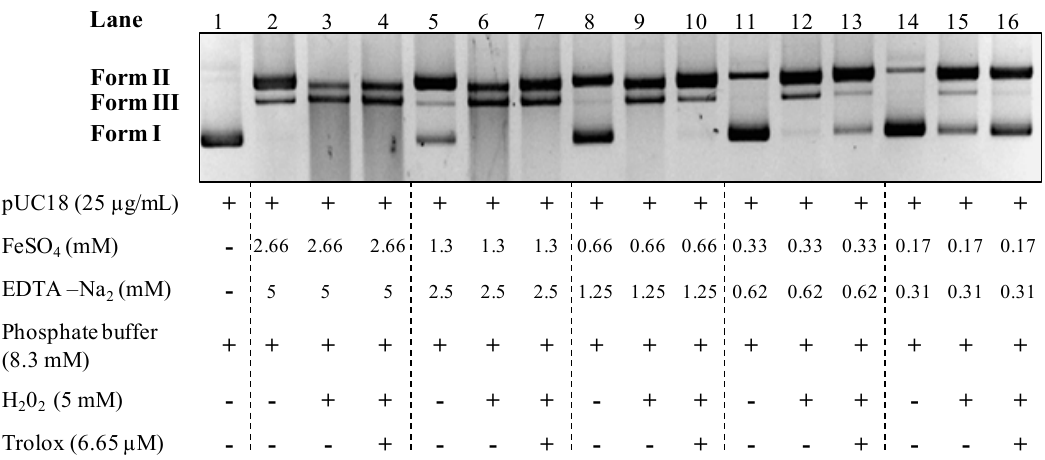
Figure 1. Aqueous DNA nicking assay optimization. Form I—supercoiled double stranded DNA; Form II—open circular DNA; Form III—nicked linear DNA. All the reaction mixtures were incubated for 20 min at 37